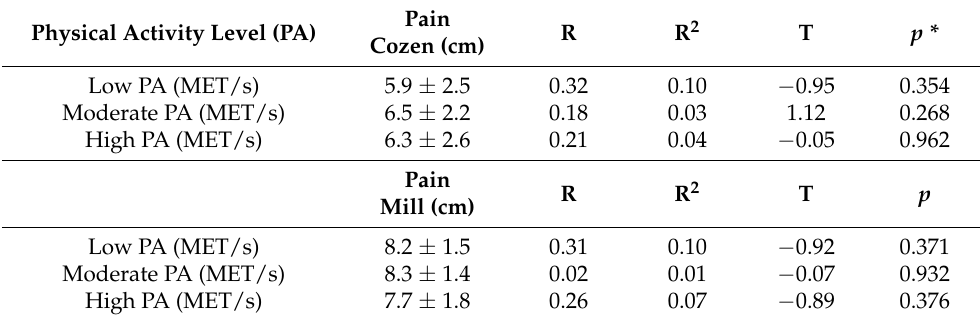
Table 5. Multiple linear regression analysis of the relationship between the energy expenditure (MET/s) of each physical activity level with the pain symptom caused during each clinical test (Cozen’s and Mill’s) in the diagnosis of lateral elbow epicondylitis in adults. Pain R R 2 T p * Physical Activity Level (PA) Cozen (cm) Low PA (MET/s) 5.9 ± 2.5 0.32 0.10 − 0.95 0.354 Moderate PA (MET/s) 6.5 ± 2.2 0.18 0.03 1.12 0.268 High PA (MET/s) 6.3 ± 2.6 0.21 0.04 − 0.05 0.962 Pain R R 2 T p Mill (cm) Low PA (MET/s) 8.2 ± 1.5 0.31 − 0.92 0.371 Moderate PA (MET/s) 8.3 ± 1.4 0.02 0.01 − 0.07 0.932 High PA